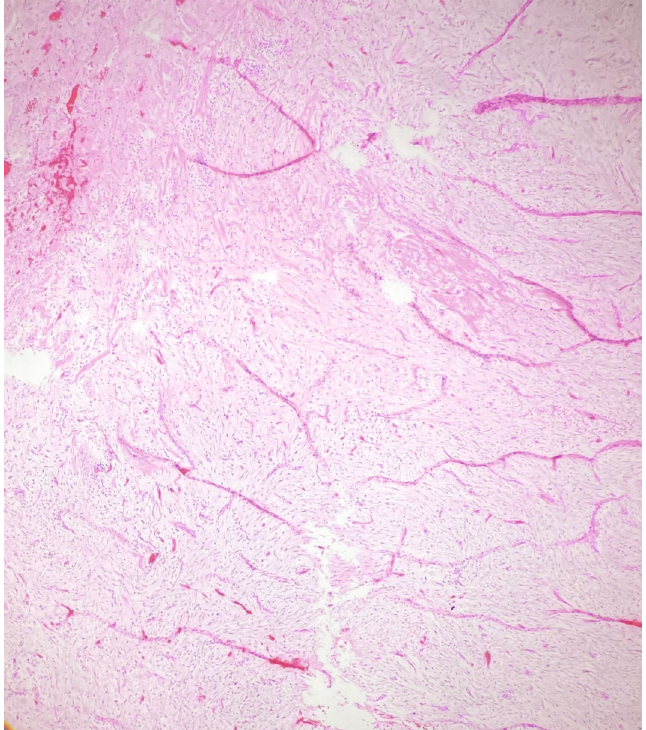
Figure 3: Aggressive angiomyxoma showing myxoid stroma and